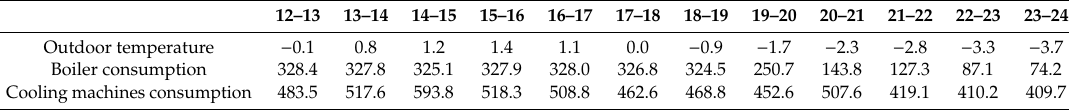
Table 5. Forecasts for the rest of the day when starting the bidding process.